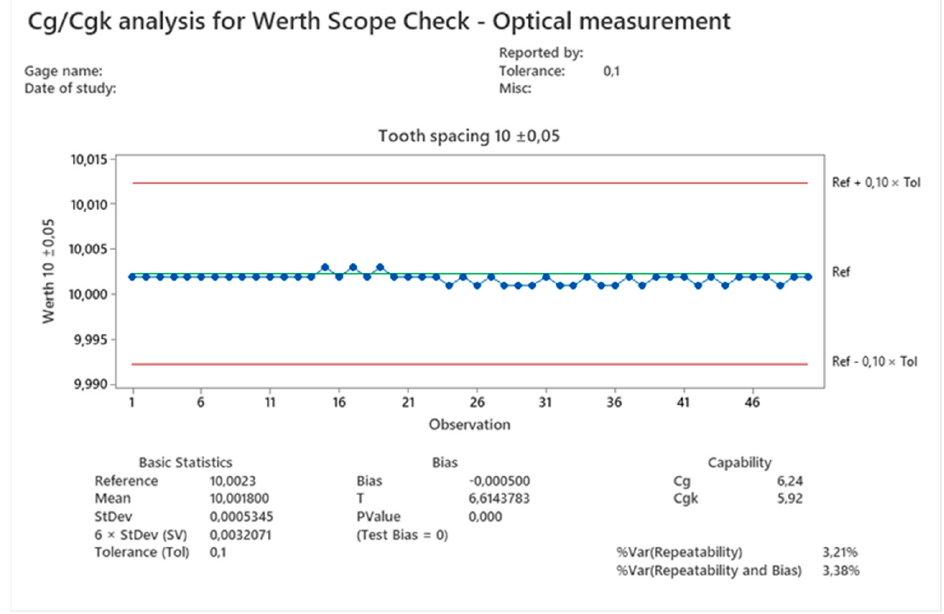
Figure 20. Tooth spacing 10 ± 0.05 mm—Cg/Cgk indicators for the Multisensory Measuring Machine Werth Scope Check (own study).